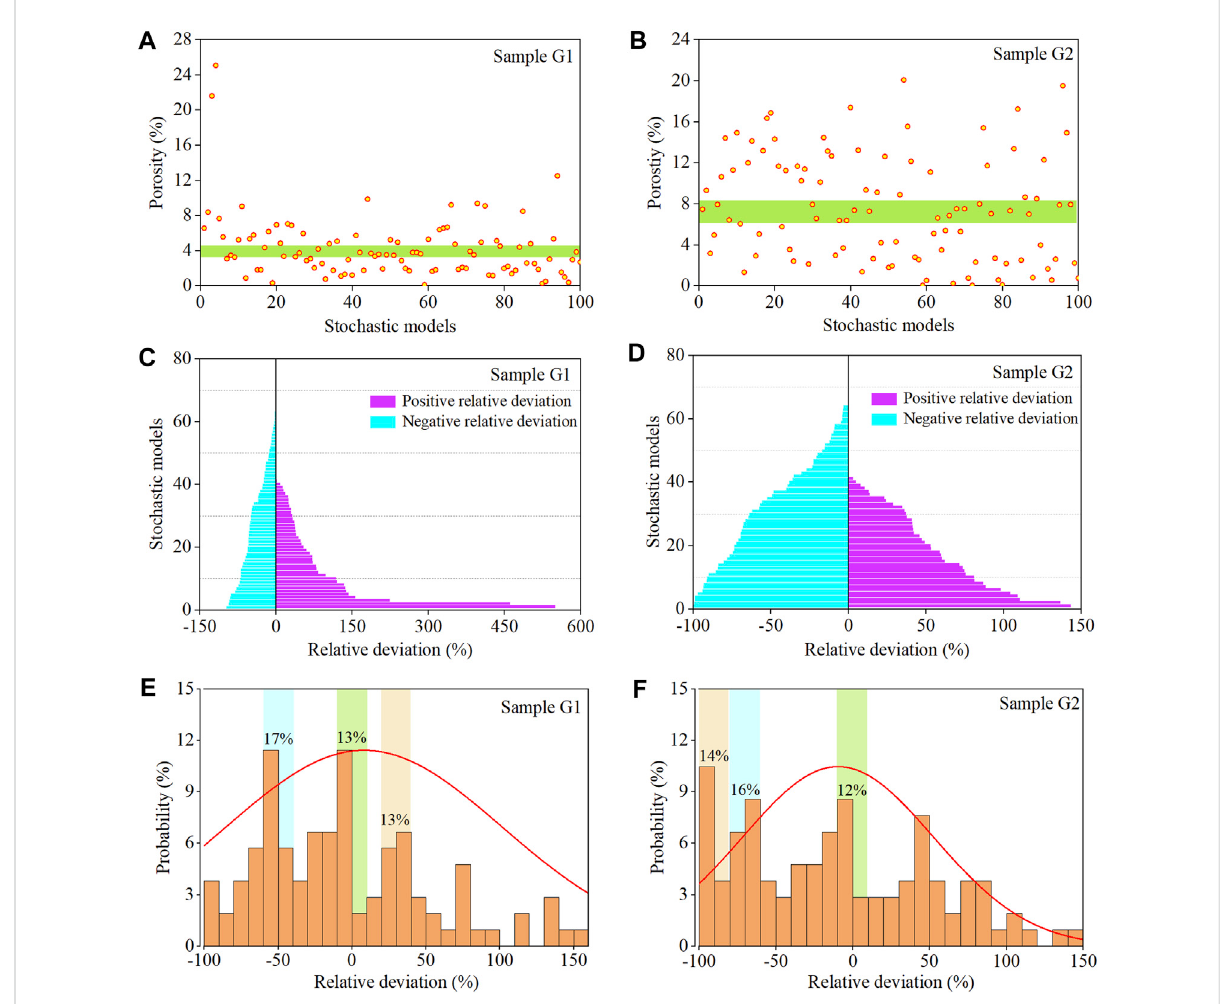
FIGURE 6 (A,B) , the porosity distribution of random small-volume models of samples G1 and G2; (C,D) , the relative deviations to the average porosity of samples G1 and G2; (E,F) , probability distribution of relative deviations of samples G1 and